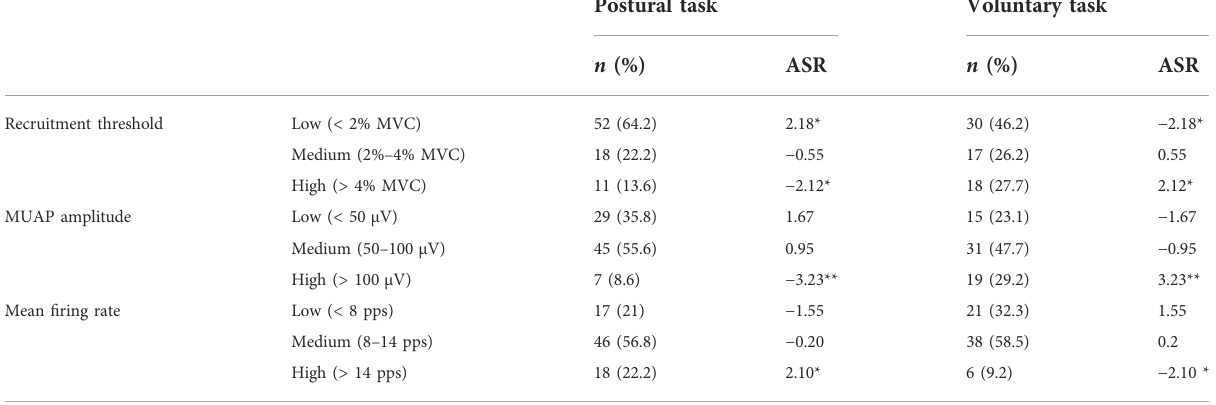
TABLE 1 Distribution of independently extracted motor units based on their fi ring properties. Postural task Voluntary